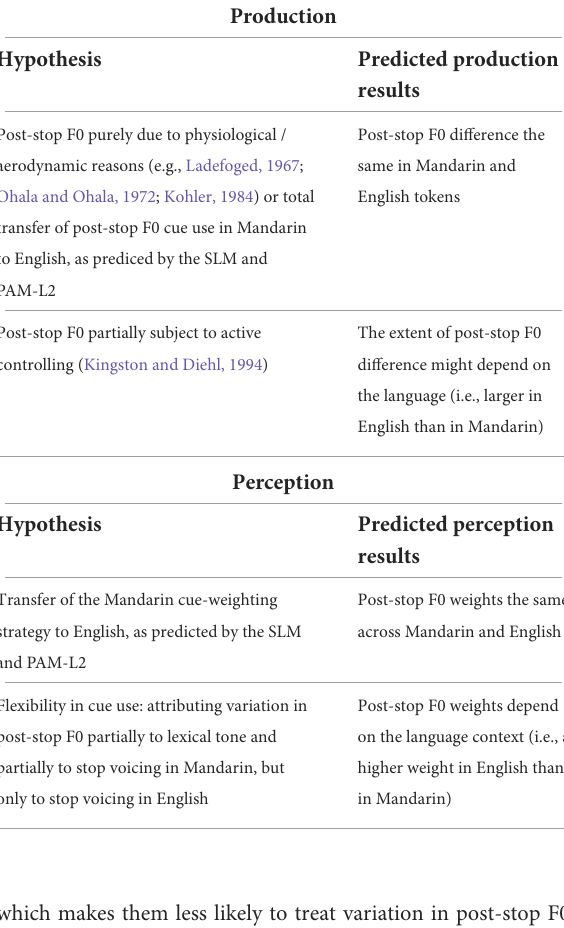
TABLE 1 Predicted production and perception results under difference